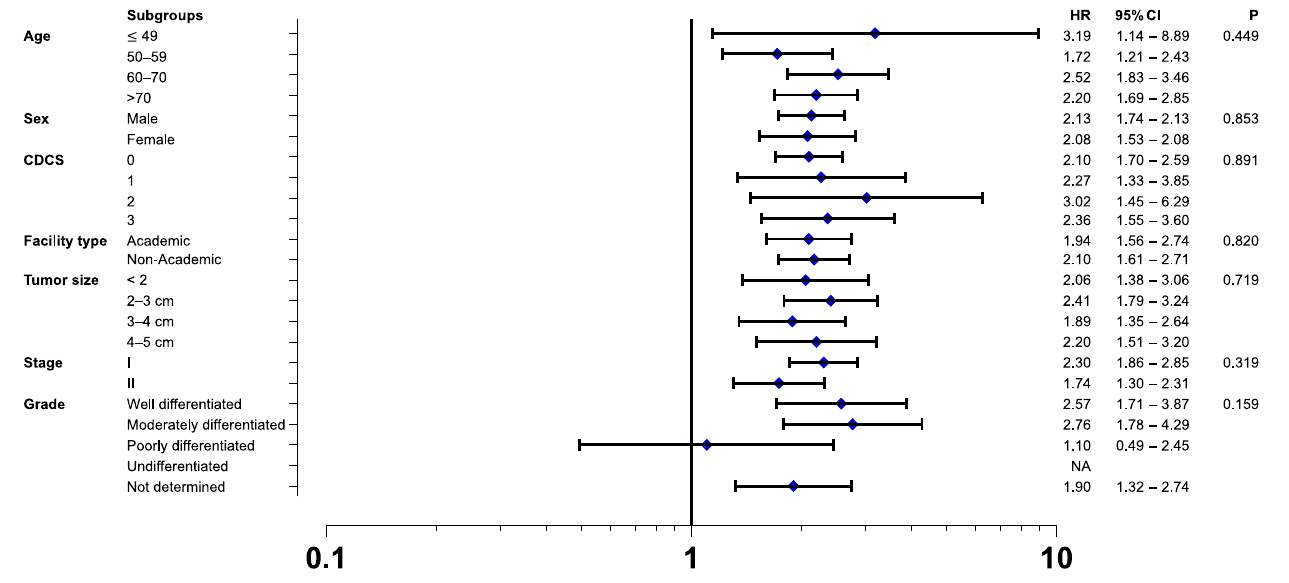
Table 2. Predictors of death (overall survival) of patients with hepatocellular carcinoma in the matched dataset.